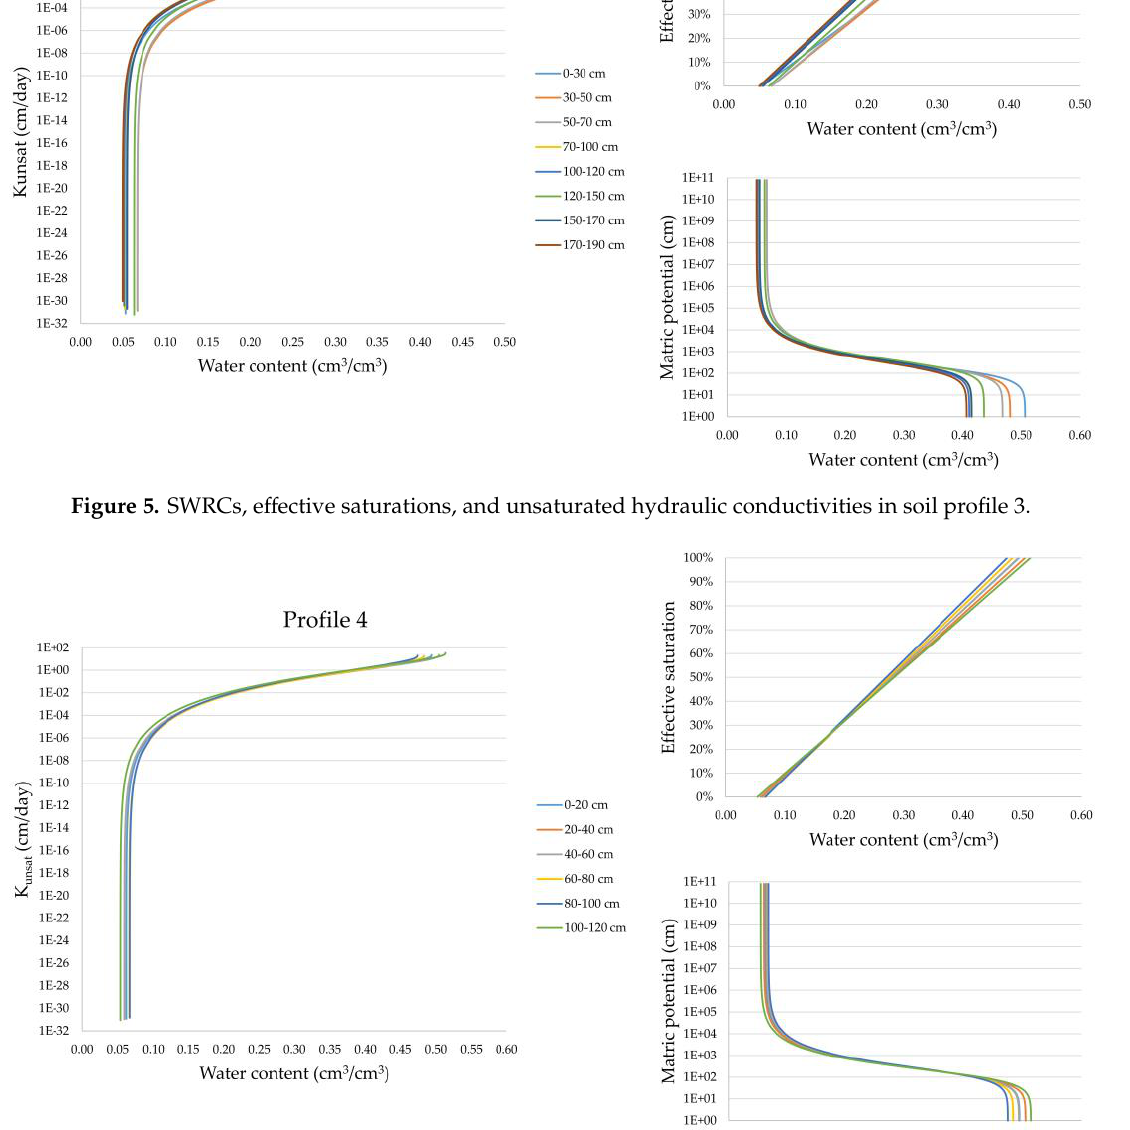
Figure 6. SWRCs, e ff ective saturations, and unsaturated hydraulic conductivities in soil profile Figure 6. SWRCs, effective saturations, and unsaturated hydraulic conductivities in soil profile 4.